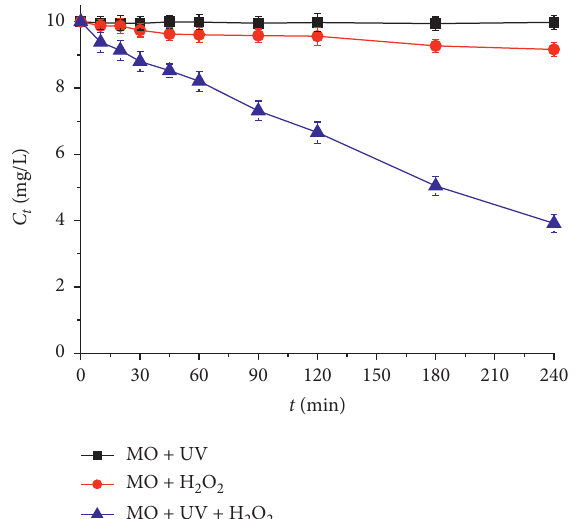
Figure 6: MO decomposition profile under different conditions in the absence of a catalyst (experimental conditions: 0.192M · H temperature: 30 ° C).